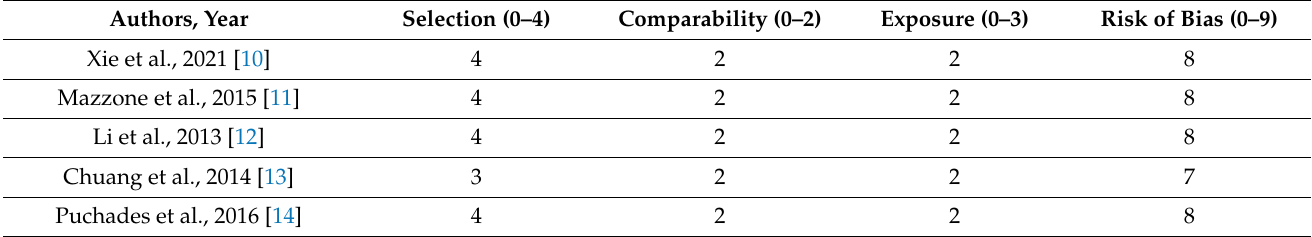
Table 1. Risk of bias for the included studies, using the modified Newcastle-Ottawa Quality Assessment Scale adapted for cross-sectional studies